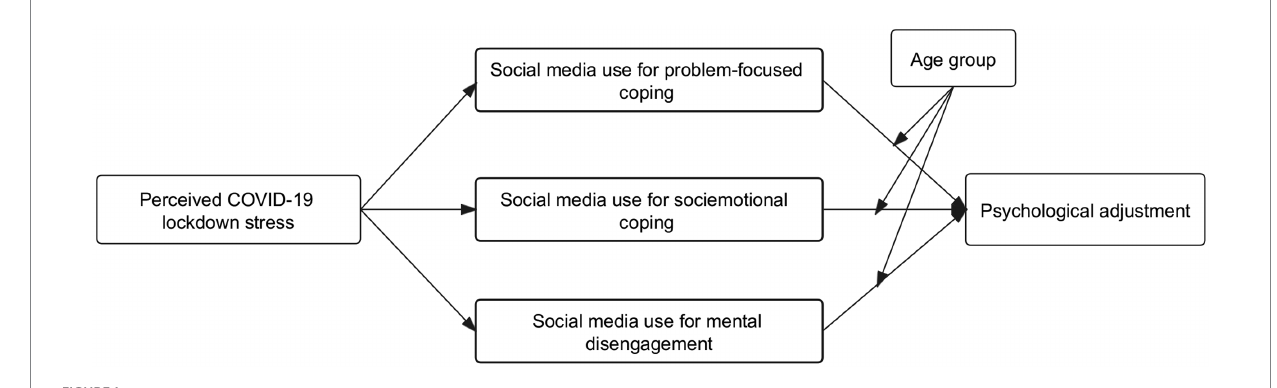
FIGURE 1 Research model in our